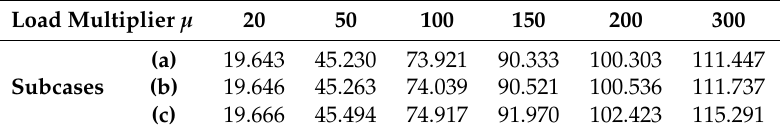
Table 3. Prescribed displacements − v ( 0,0, L ) adopted in the FE